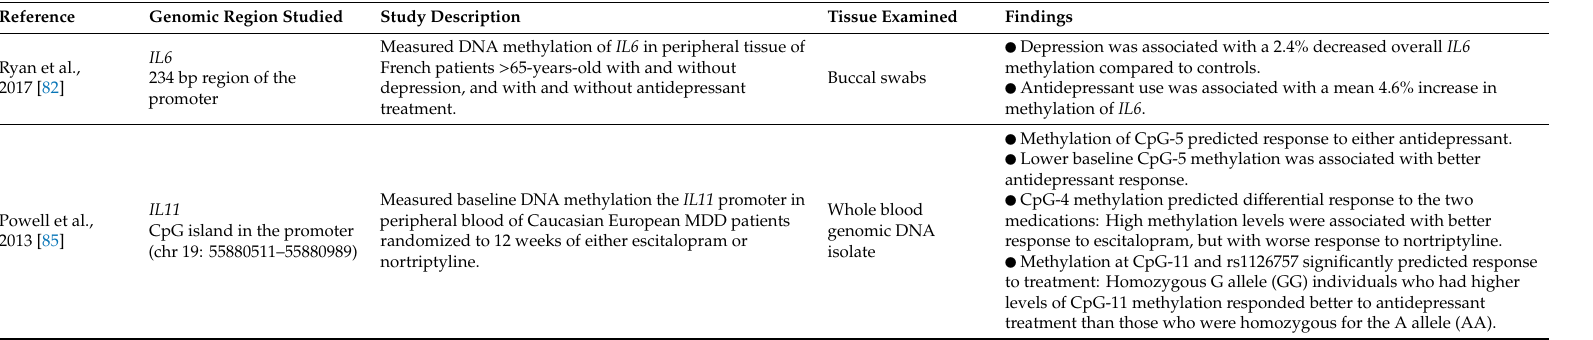
Table 5. Summaries of studies exploring relationship of antidepressants and DNA methylation of cytokine genes.